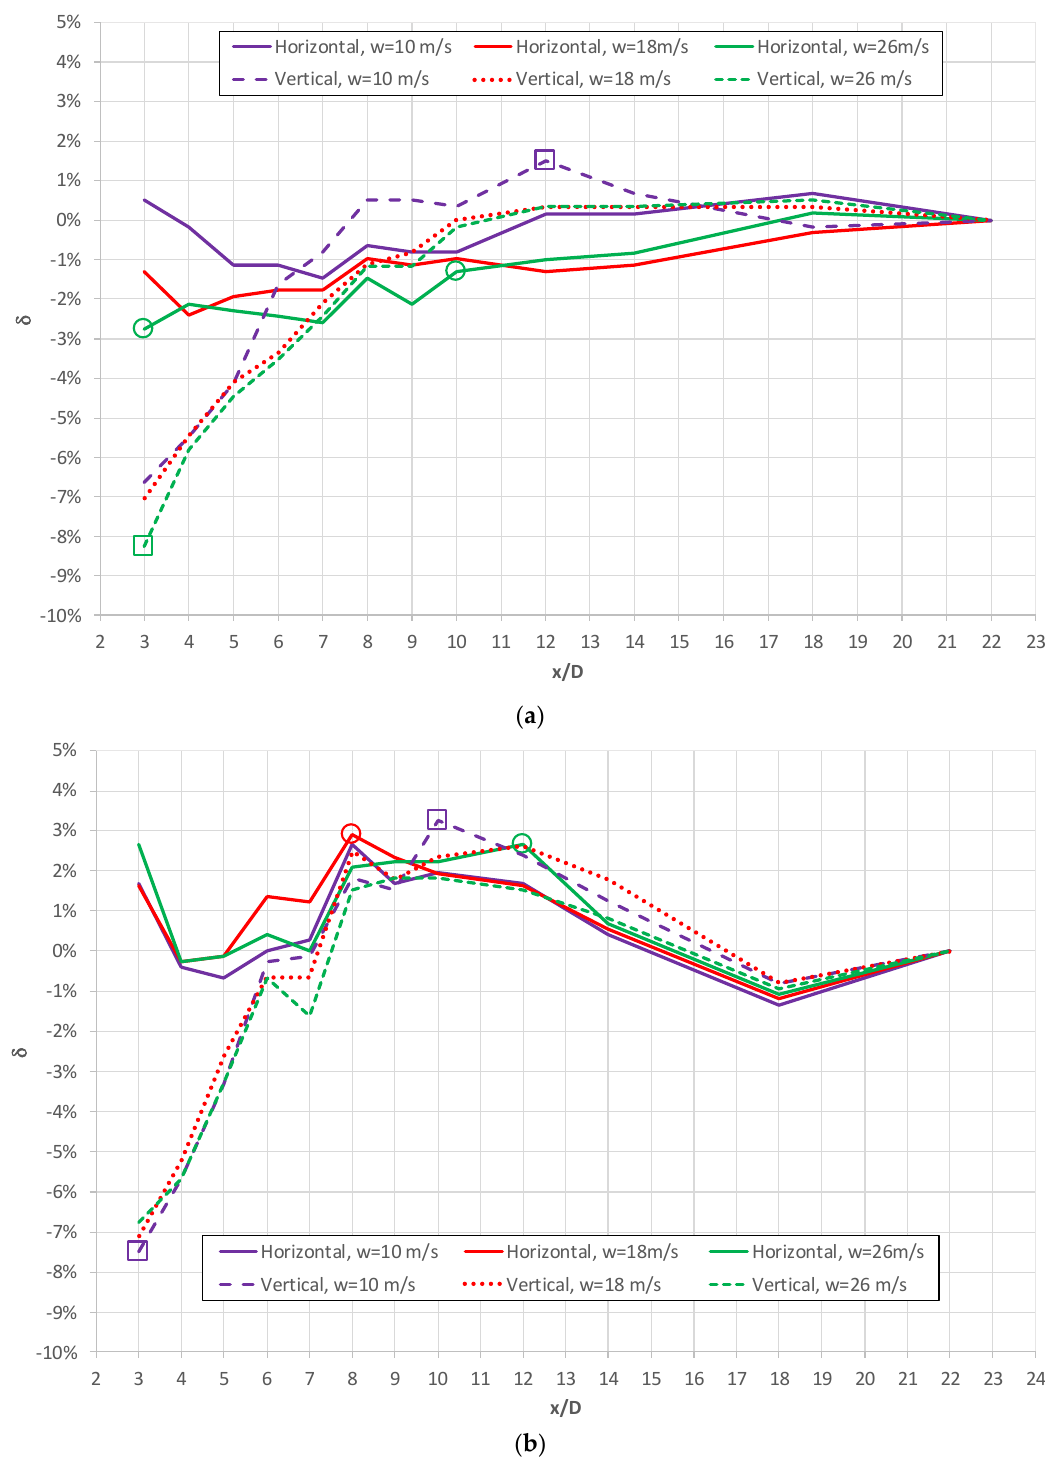
Figure 7. Results of additional error δ for various distances downstream of an elbow with radius of curvature R c = 1D (additional symbol means maximum additional error—square for vertical position and circular for horizontal position of probe, respectively) for cases of: ( a ) circular and ( b ) streamlined probes (based on data from [24]).